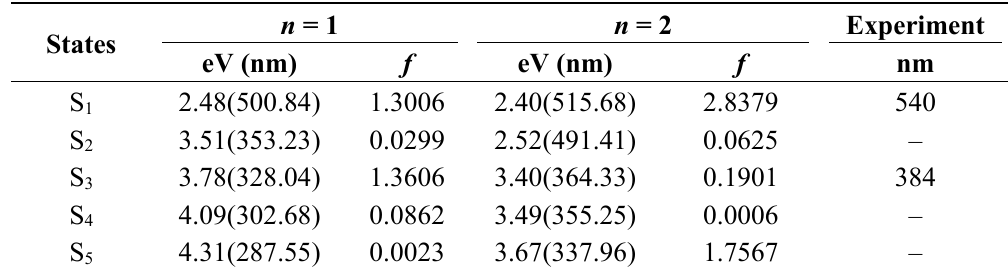
Table 1. Calculated transition energies (eV, nm) and oscillator strengths ( f ) for polymer ( n = 1 and n =